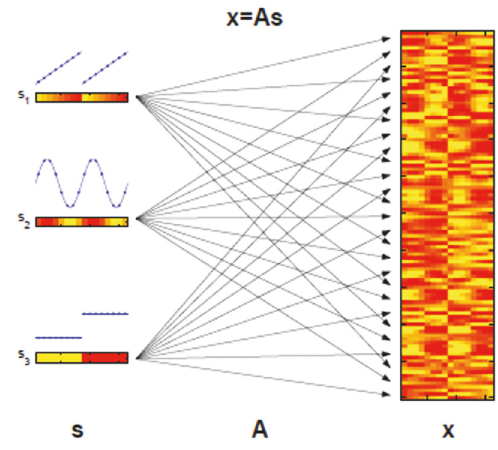
Figure 2: x represents the mixture of the components of mixture A and the set of independent signals s